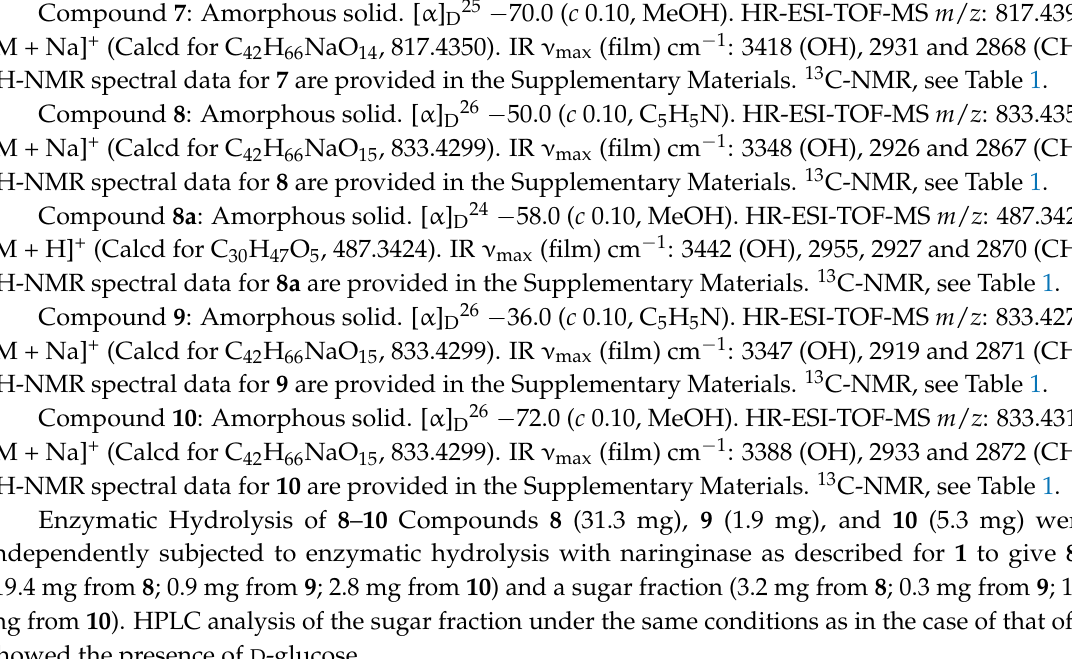
Compound 7 : Amorphous solid. [ α ] D25 − 70.0 ( c 0.10, MeOH). HR-ESI-TOF-MS m / z :